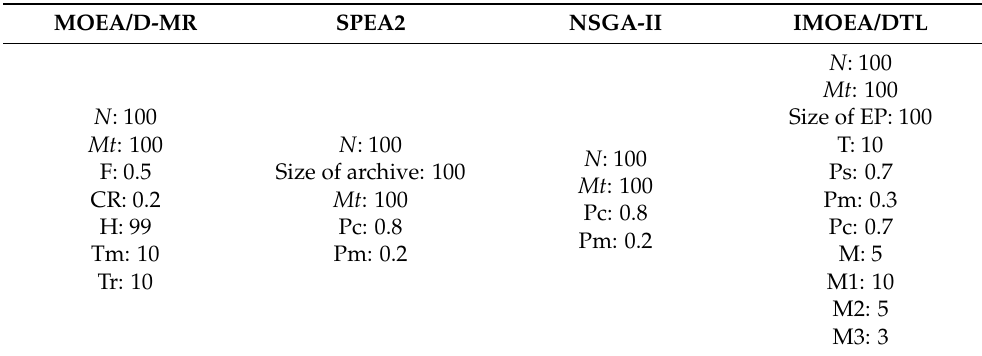
Table 7. Parameters setting of MOEA/D-MR, Strength Pareto Evolutionary Algorithm 2 (SPEA2), Non-dominated Sorting Genetic Algorithm II (NSGA-II), and MOEA/DTL by Variable Neighborhood Search